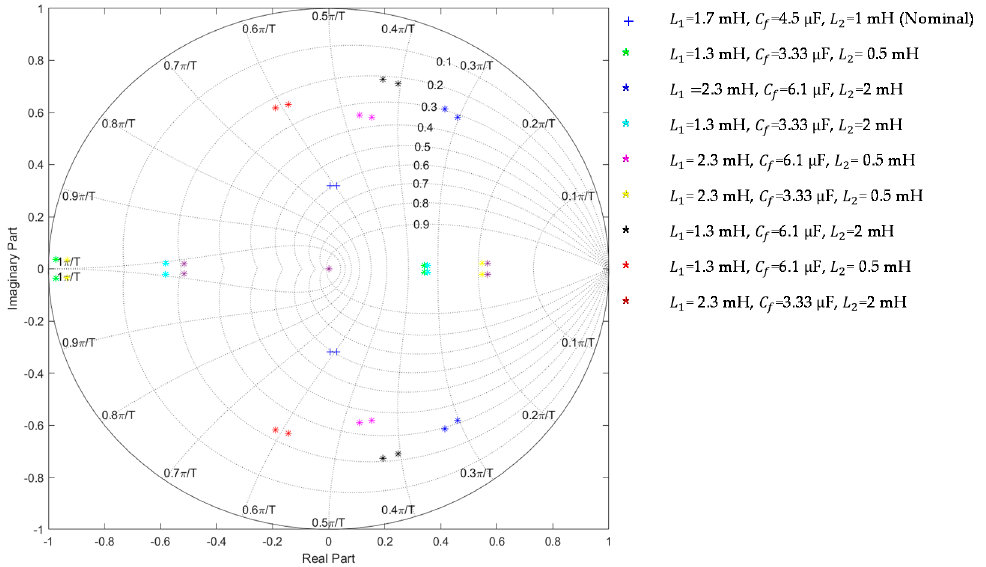
Figure 5. Eigenvalues of the LMI-based current-type full-state observer under uncertainties of LCL filter parameters.